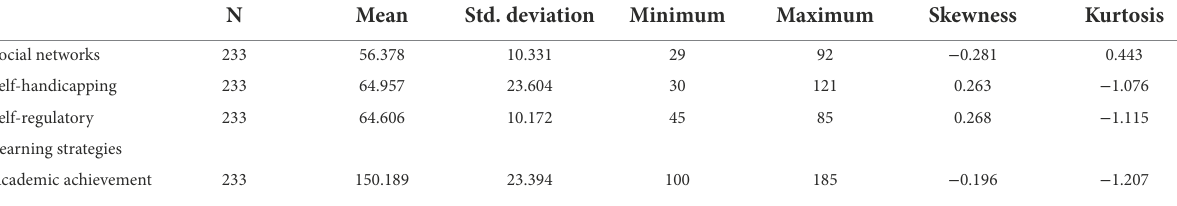
TABLE 2 Central indicators and dispersion of research variables.